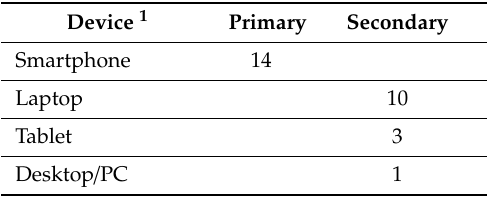
Table 3. Device use (primary and